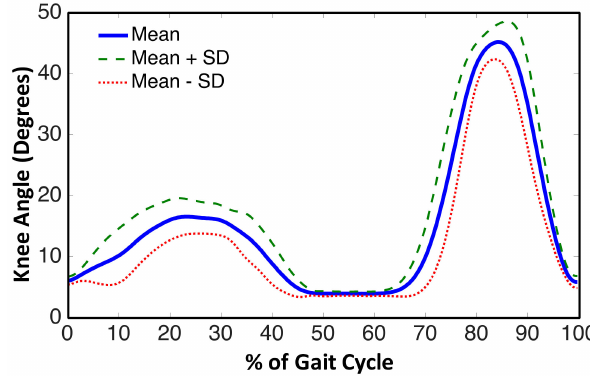
Figure 10. Gait kinematics measured during